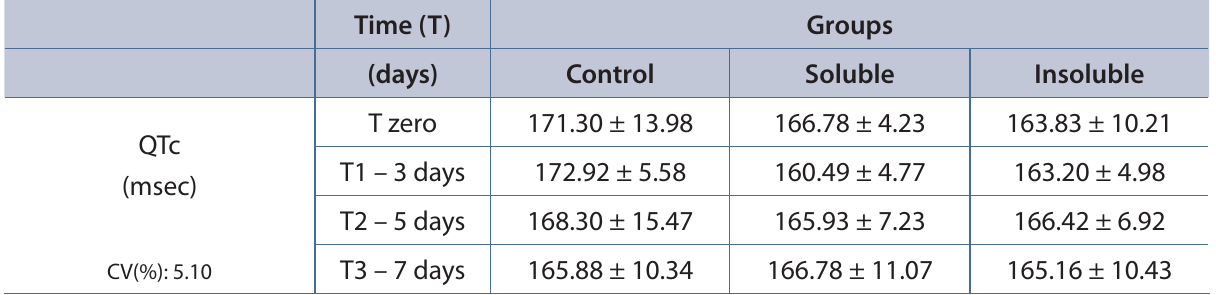
Table 7. Mean values of QTc interval (msec) in rabbits submitted to gavage with ultra-pure water (CG), water-soluble A. rigida extract (SG) and water-insoluble A. rigida extract (IG) at different